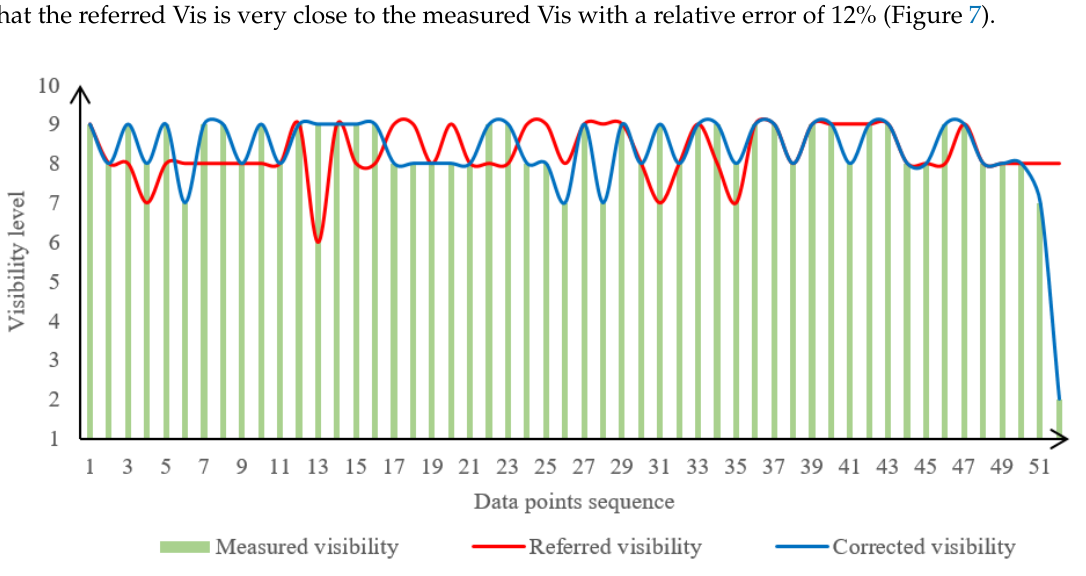
Figure 6. The relative error of referred Vis from Equation (4) against observations obtained from the Chinese Ninth Arctic Science Examination (CNASE).